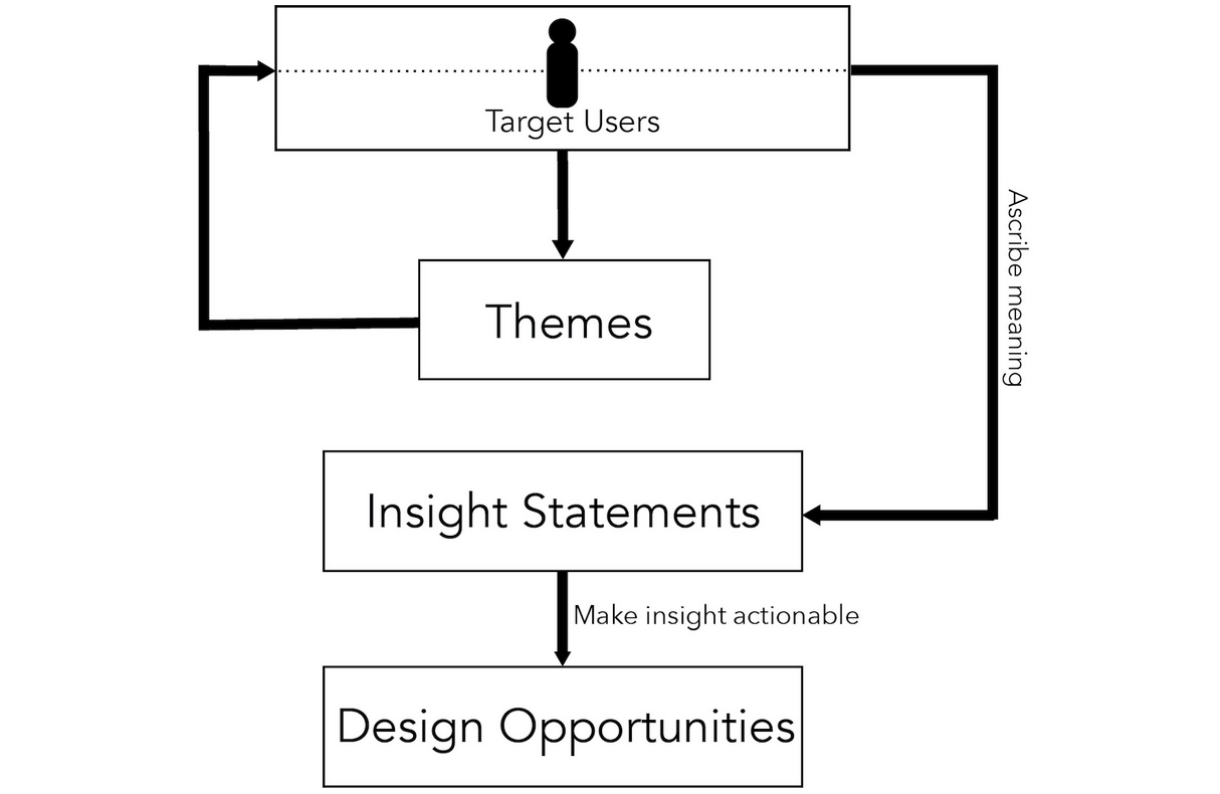
Figure 2. Process for developing insights and opportunities using human-centered